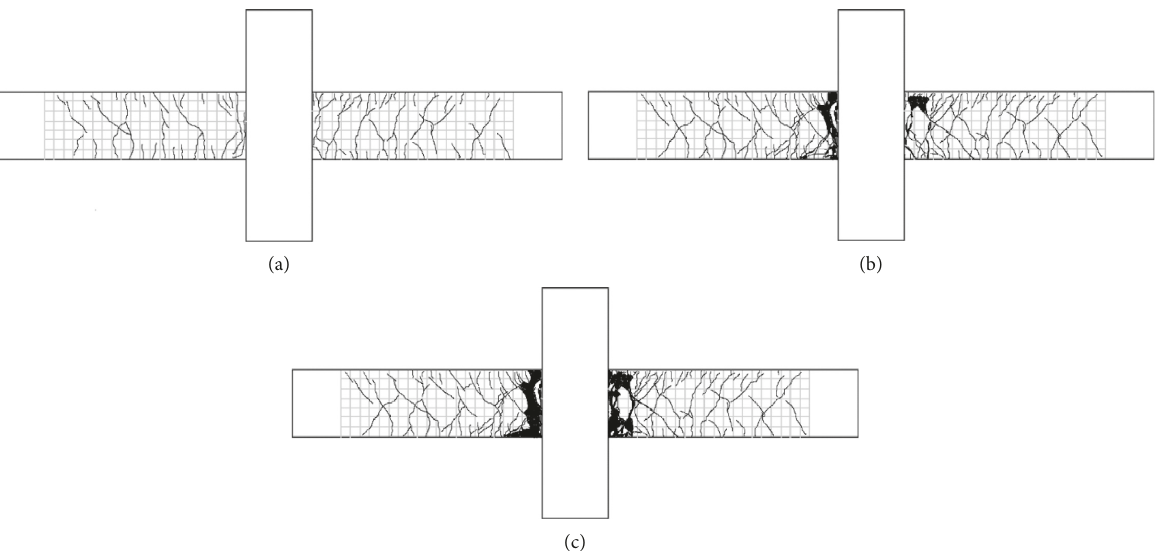
Figure 8: Crack development process of XJJD: (a) yielding stage, (b) peak load stage, and (c) failure